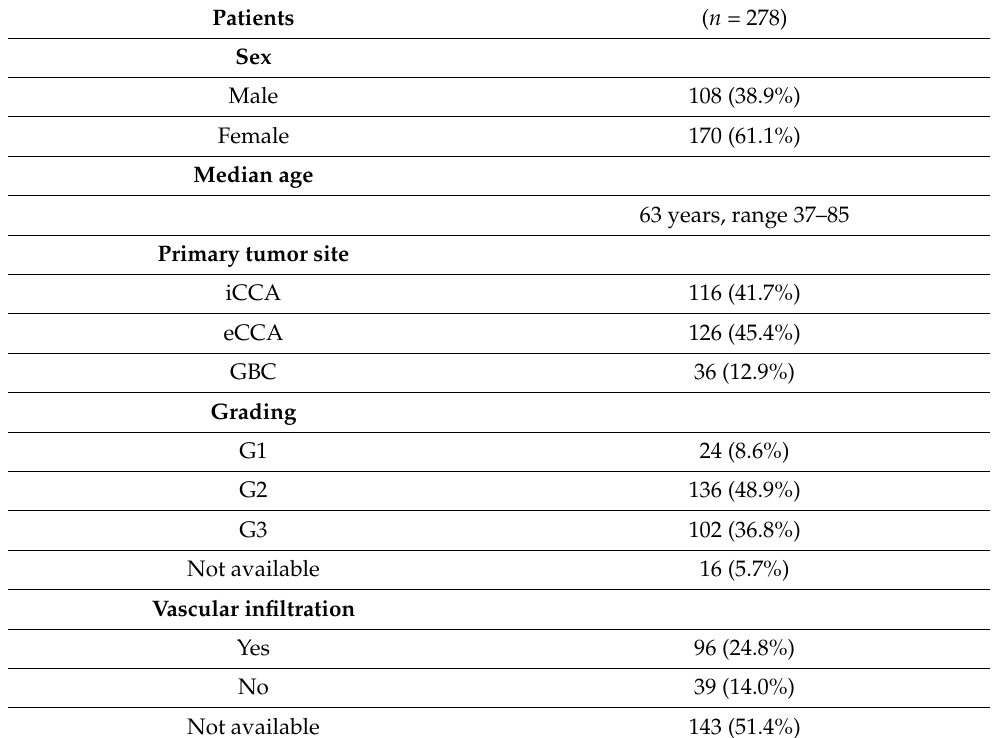
Figure 1. The study flow chart of the included patients. Table 1. Baseline characteristics of